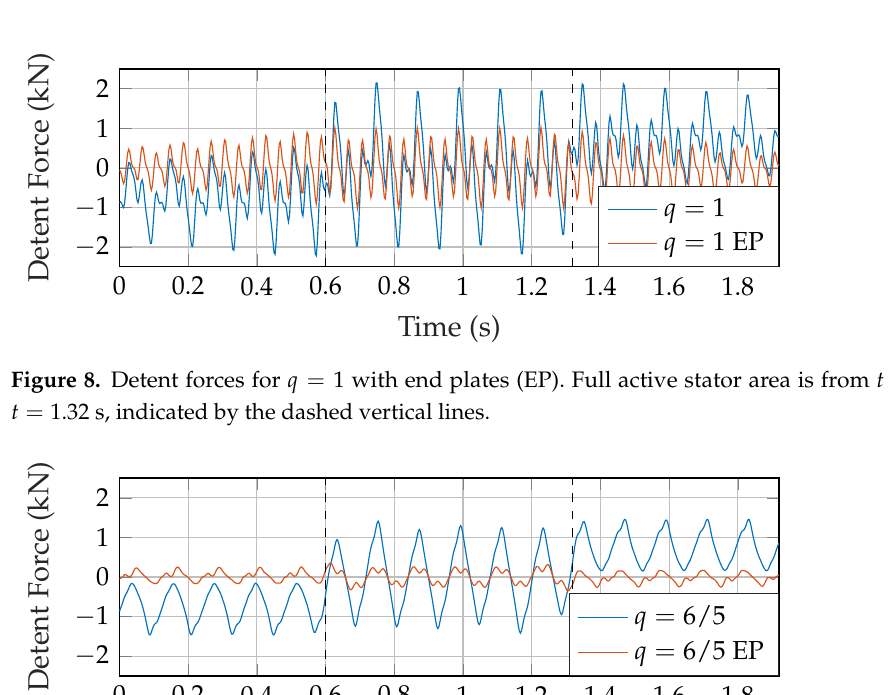
. The stroke length allows 5